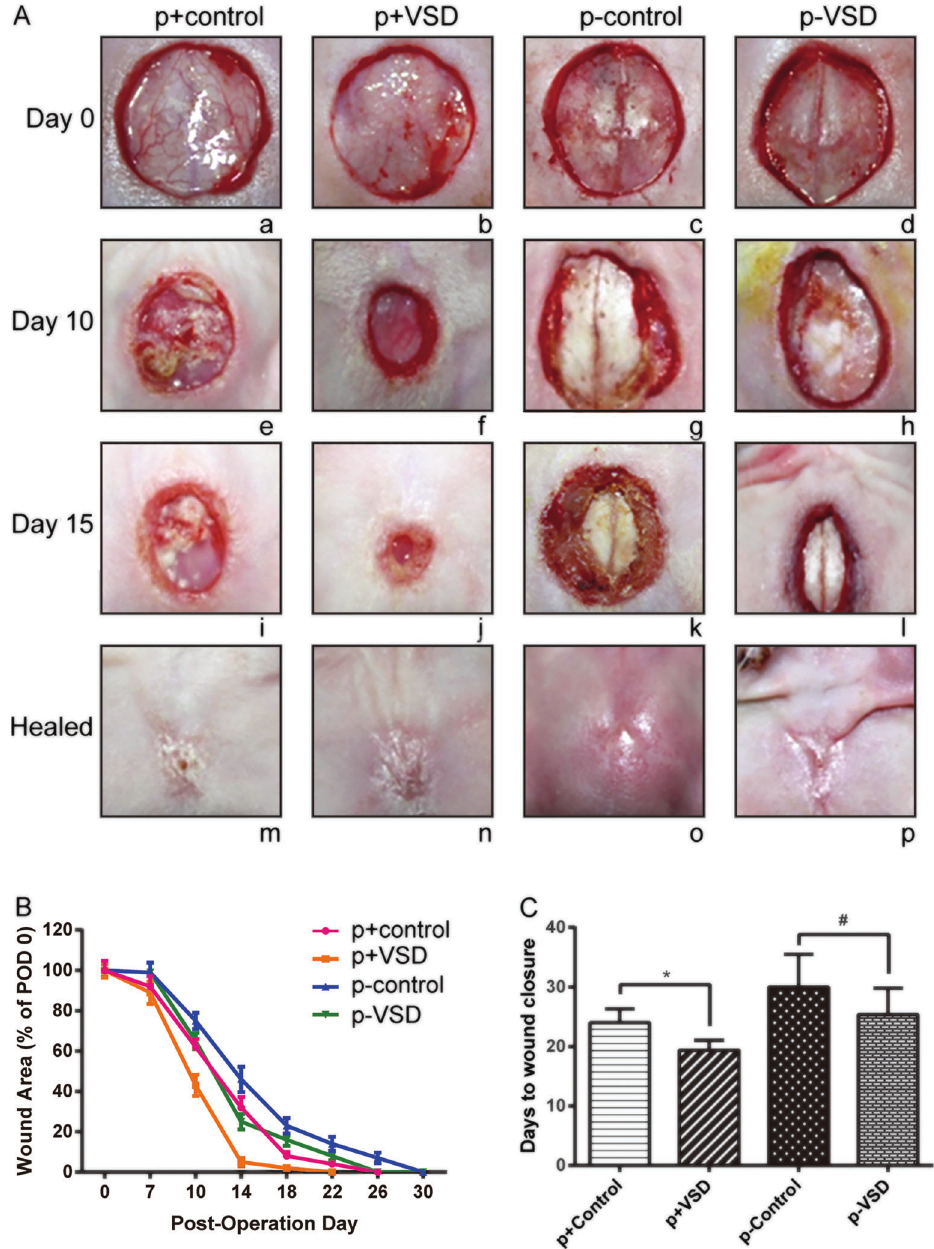
Figure 1. VSD therapy accelerated wound healing. A , Effect of VSD on the gross appearance of wound healing on post-operative days (POD) 0, 10, 15 and after healing, in skull exposure wounds in rabbits. B , Wound closure rate was assessed based on wound size measurements. p + : periosteum-intact; p – : periosteum-lacking; Control: traditional dressing therapy; VSD: vacuum sealing drainage. Data are reported as means ± SD. *P o 0.05 compared to p + Control, # P o 0.05 compared to p – Control ( t